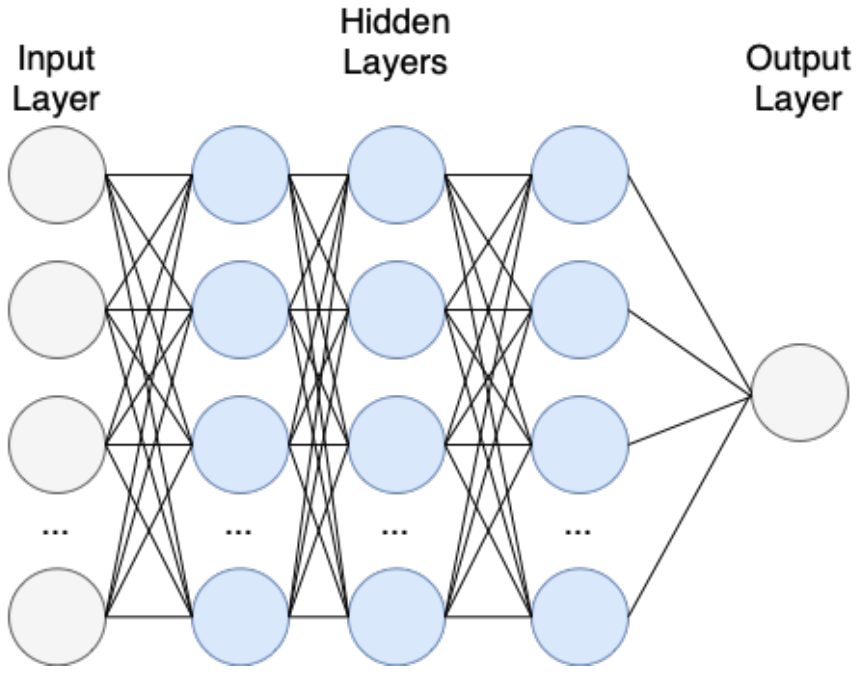
Figure 1. Example of Deep Neural Network (DNN) [14,15].